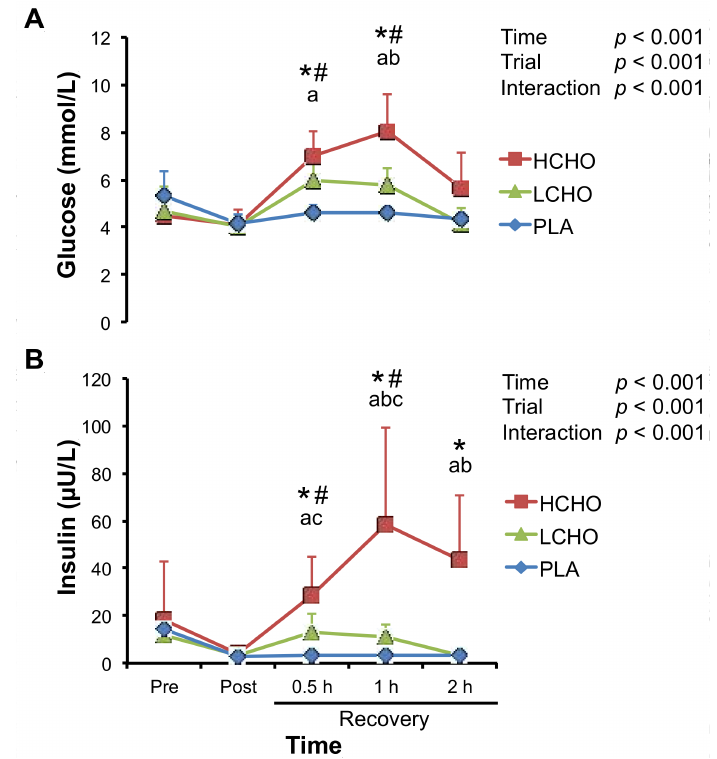
Figure 1. Changes in plasma glucose ( A ) and serum insulin ( B ) concentrations in response to endurance exercise. HCHO, high-carbohydrate trial; LCHO, low-carbohydrate trial; PLA, placebo trial; Pre, pre-exercise; Post, immediately after exercise; 0.5 h, 0.5 h after exercise; 1 h, 1 h after exercise; 2 h, 2 h after exercise. * p < 0.05 vs. Pre for HCHO trial. # p < 0.05 vs. Pre for LCHO trial. a p < 0.05, HCHO vs. PLA. b p < 0.05, HCHO vs. LCHO. c p < 0.05, LCHO vs. PLA.